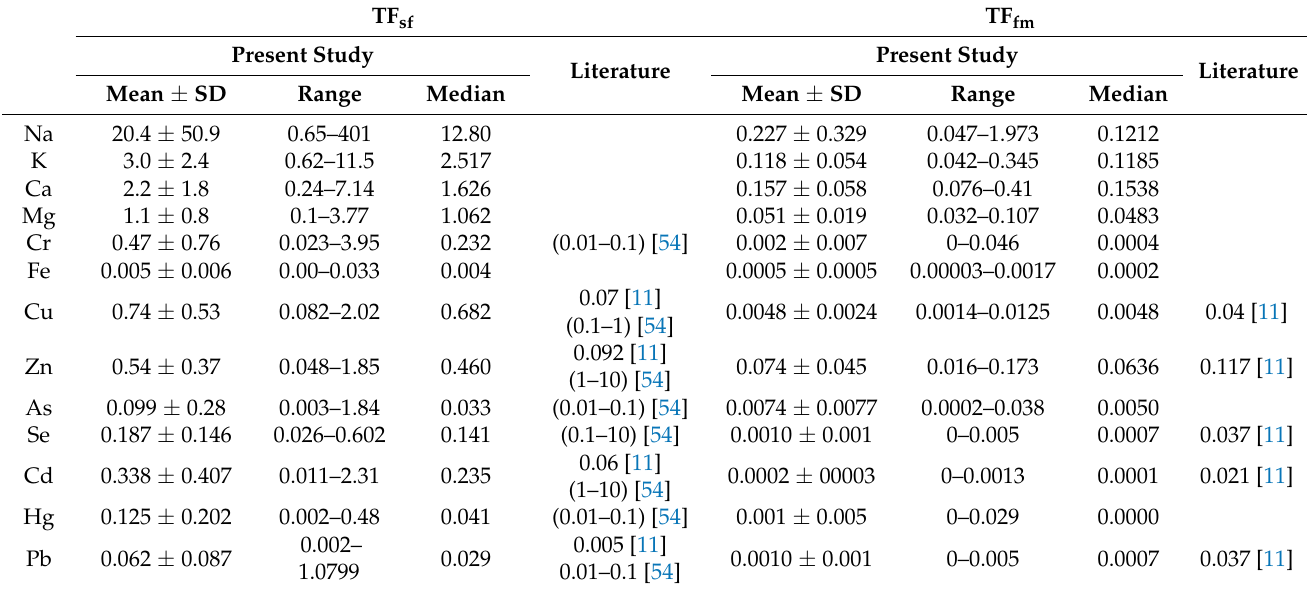
Table 5. Soil–forage (TF sf ) and forage–milk (TF fm ) transfer factors for potentially toxic